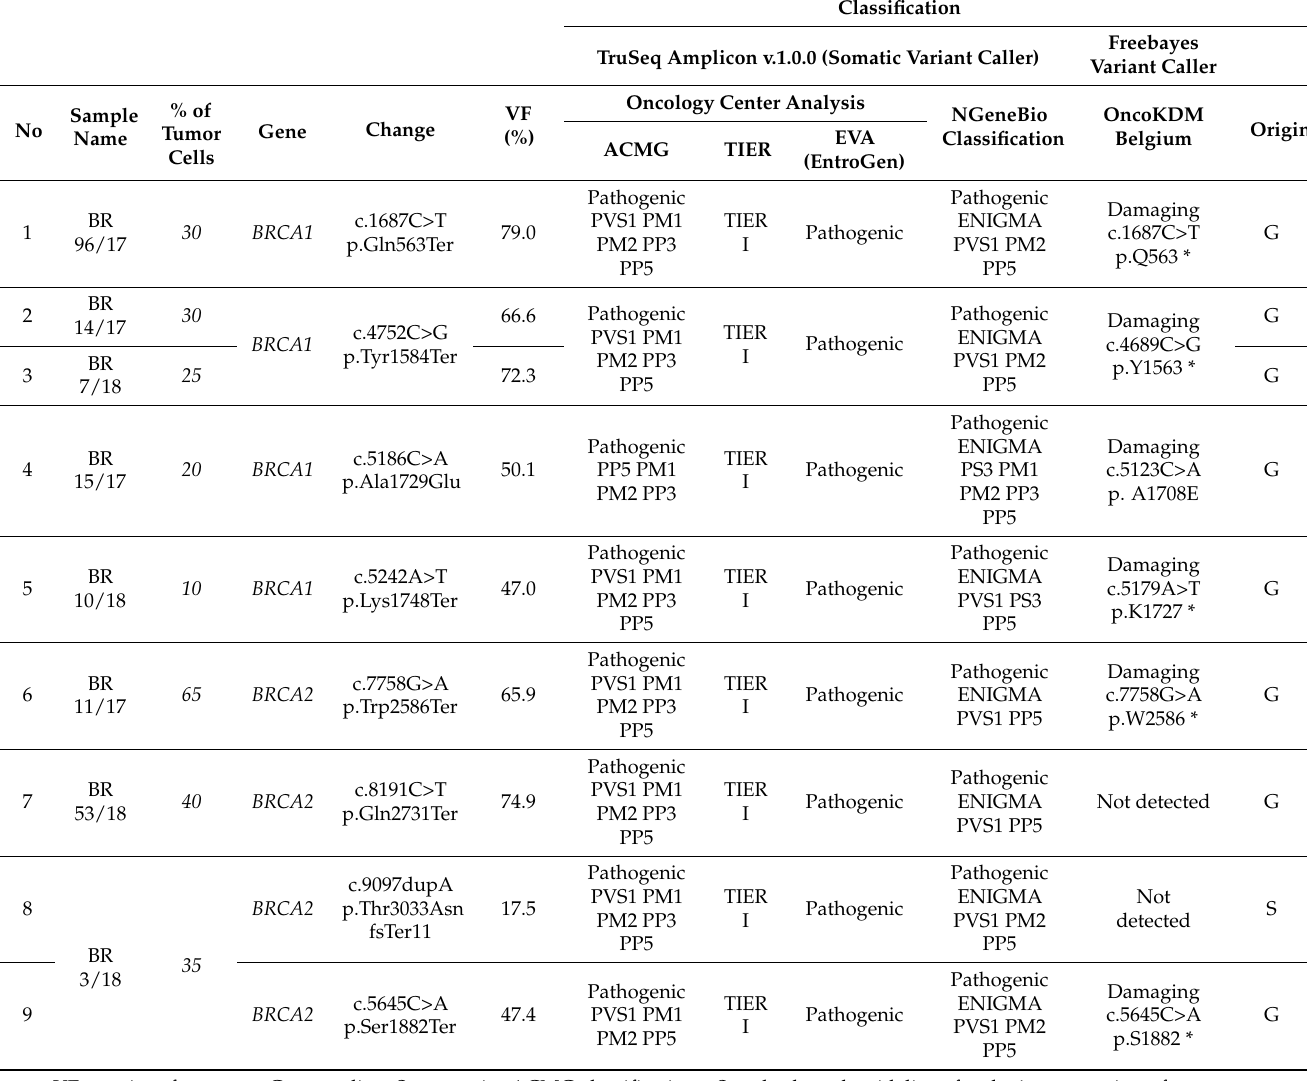
Table 3. Analysis of 9 detected pathogenic variants in 75 selected patients with breast